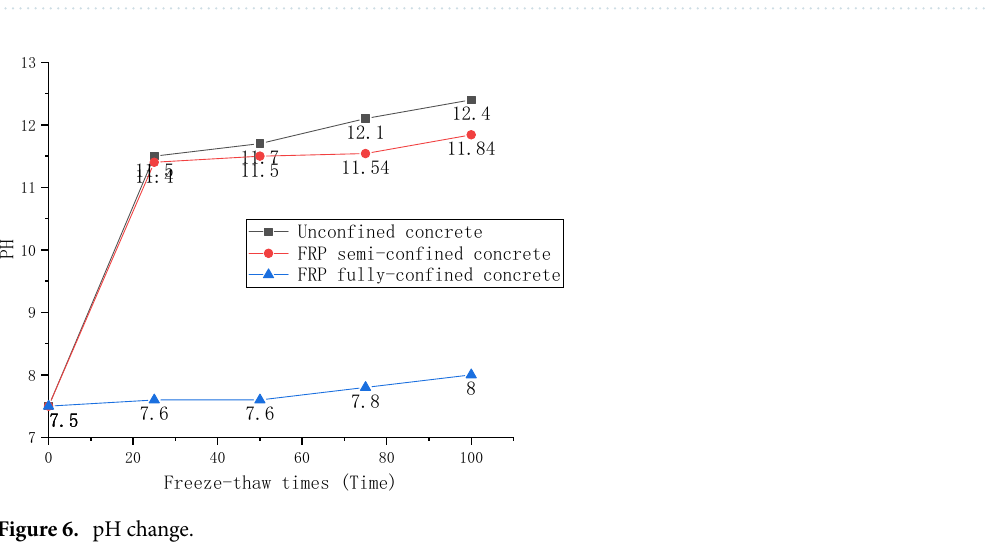
Figure 5. Internal microscope observation of concrete column section: (a) FRP fully confined; (b) FRP semi- confined; (c)